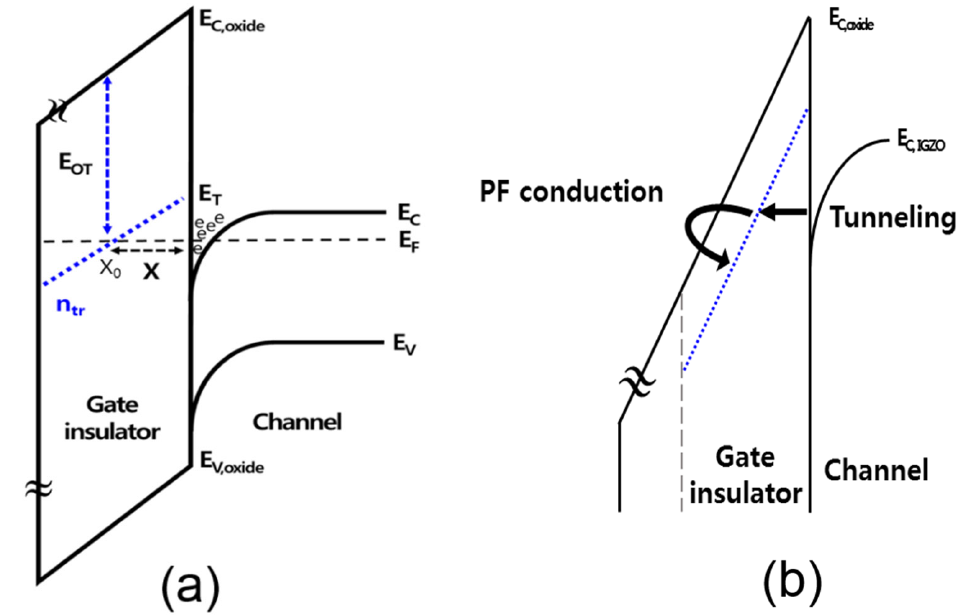
Figure 7. ( a ) Energy band diagram for the IGZO TFT under PBTS, in which x represents the direction from the IGZO/SiO 2 interface to SiO 2 . ( b ) PBTS-induced electron tunneling from IGZO to SiO 2 and PF conduction of trapped electrons in SiO 2 .